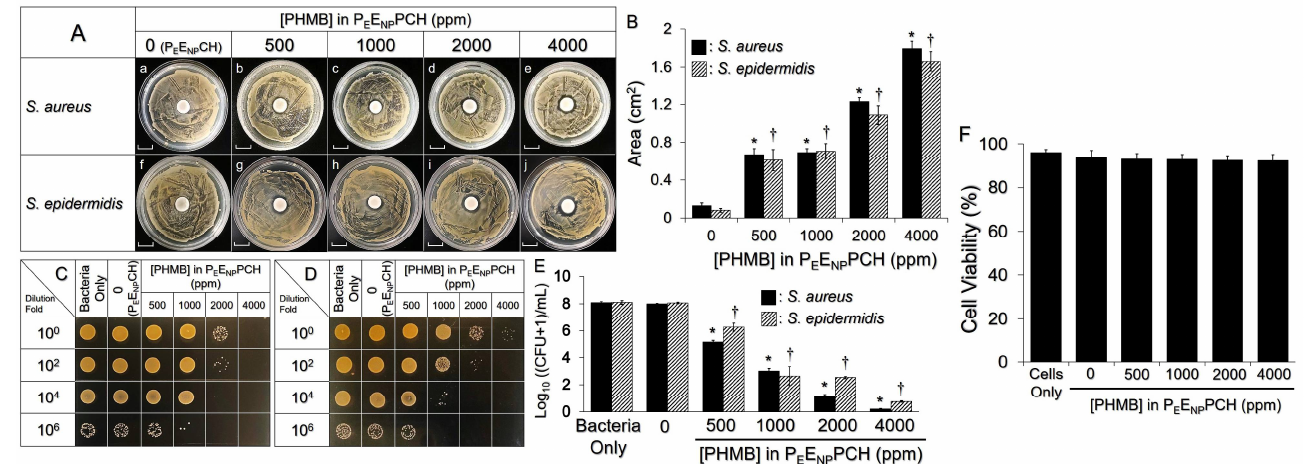
Figure 4. Antimicrobial and cytotoxic effects of P E E NP PCH containing various doses of PHMB. ( A ) Images of the inhibition zone of S. aureus ( a – e ) or S. epidermidis ( f – j ) generated by the P E E NP PCH containing 0 (P E E NP CH), 500, 1000, 2000, and 4000 ppm PHMB. Each group was photographed after treatment with the hydrogel for 24 h. Scale bar = 1.0 cm. ( B ) Quantitative analyses of the inhibition zones shown in ( A ). ( C , D ) Images of S. aureus ( C ) and S. epidermidis ( D ) colonies after treatment with P E E NP CH or P E E NP PCH containing various PHMB dosages as indicated in the figure. Images in the four rows represent the colony forming conditions of the group using bacteria with different dilutions as the seed. All images were captured 12 h after inoculation on TSB agar plates. ( E ) Quantitative analyses of the MPI of S. aureus or S. epidermidis shown in ( C , D ). Values are presented as mean ± s.d. (n = 3). * p < 0.05 compared to the S. aureus group treated with the P E E NP CH. † p < 0.05 compared to the S. epidermidis group treated with the P E E NP CH. ( F ) Toxicity of P E E NP PCH containing 0 (i.e., P E E NP CH), 500, 1000, 2000, or 4000 ppm PHMB to KERTr cells after treatment for 24 h. Values are presented as the mean ± s.d. (n = 3).